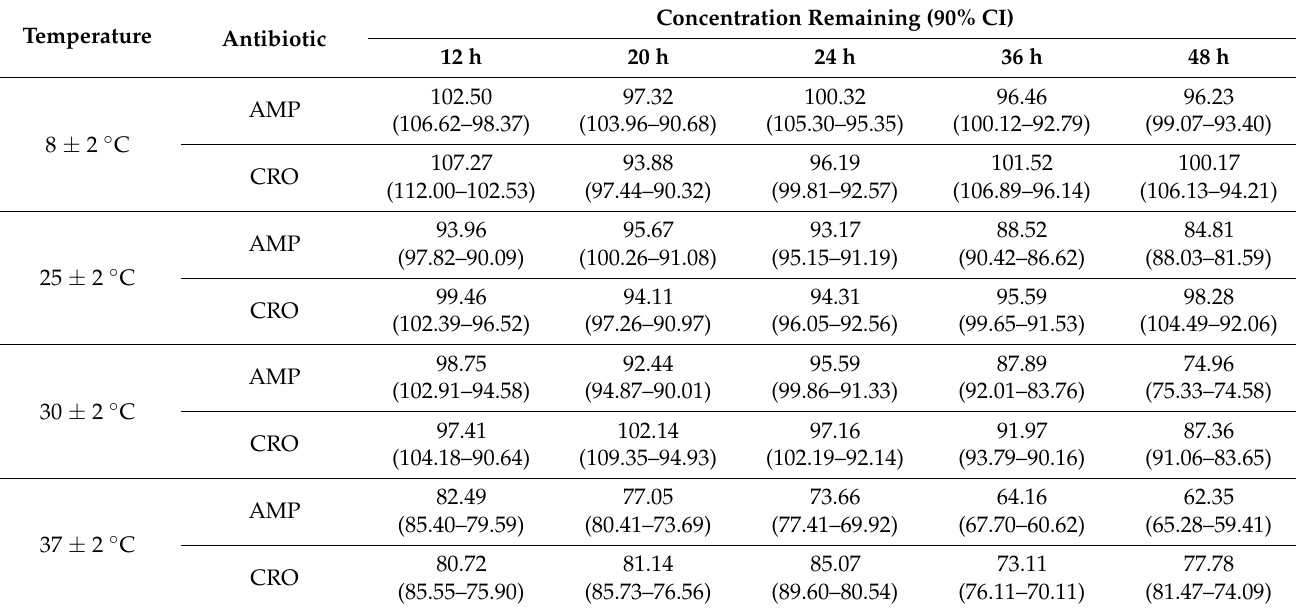
Table 1. Stability at 8 ± 2 ◦ C, 25 ± 2 ◦ C, 30 ± 2 ◦ C and 37 ± 2 ◦ C.